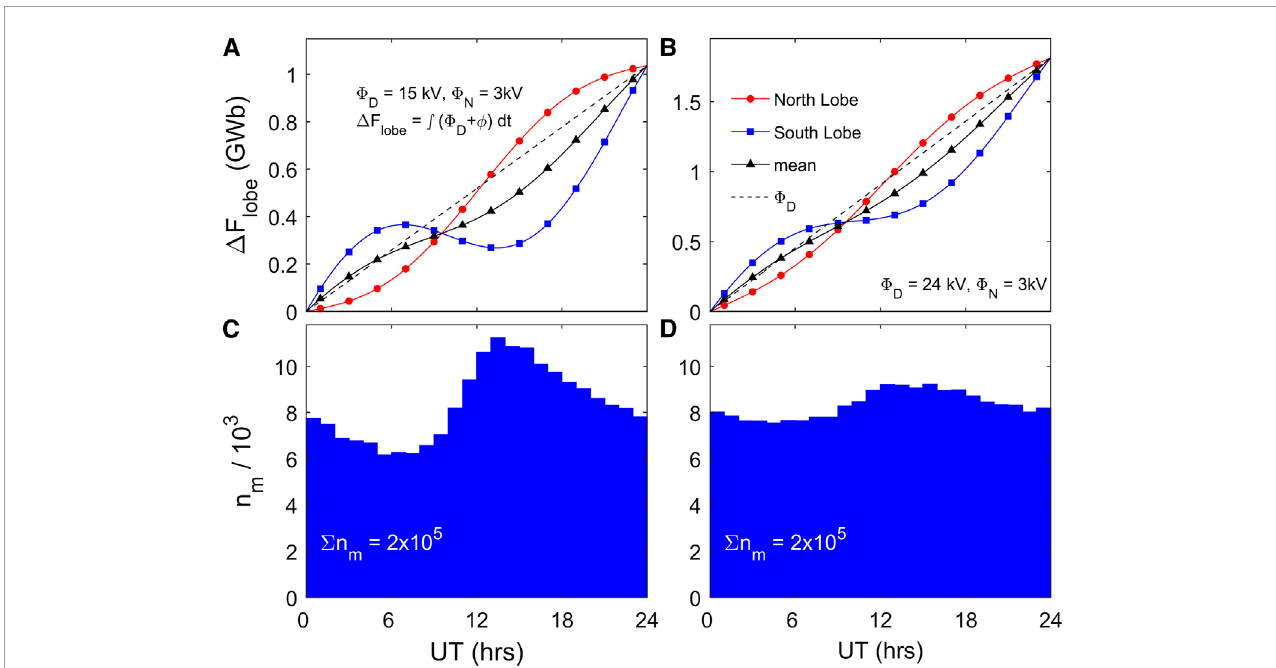
FIGURE 16 The results of a simple model of how the UT variation in substorm onset occurrence can be caused by the pole motion effect. The upper panels show the UT variations of magnetic flux accumulation in the tail lobes, Δ F = ∫ ( Φ D − Φ N + ϕ ) dt : red (with red circle symbols) is for the northern hemisphere Δ F N = ∫ ( Φ D − Φ N + ϕ n ) dt , blue (with blue square symbols) for the south Δ F S = ∫ ( Φ D − Φ N + ϕ s ) dt and black (with black triangle symbols) is the mean of the two Δ F M = (Δ F N +Δ F S )/ 2. In (A) Φ D = 15 kV (the mode of the distribution for 2-h intervals) and Φ N = 3 kV . In (B) Φ D = 24 kV (the mean of the distribution) and Φ N = 3 kV . Parts (C) and (D) show histograms of the numbers of onsets predicted by the simple model, n m , as a function of UT . In the model, the onsets are triggered stocastically based on a probability that varies linearly with the mean lobe flux F M = ( F N + F S )/ 2 (See text for further details).